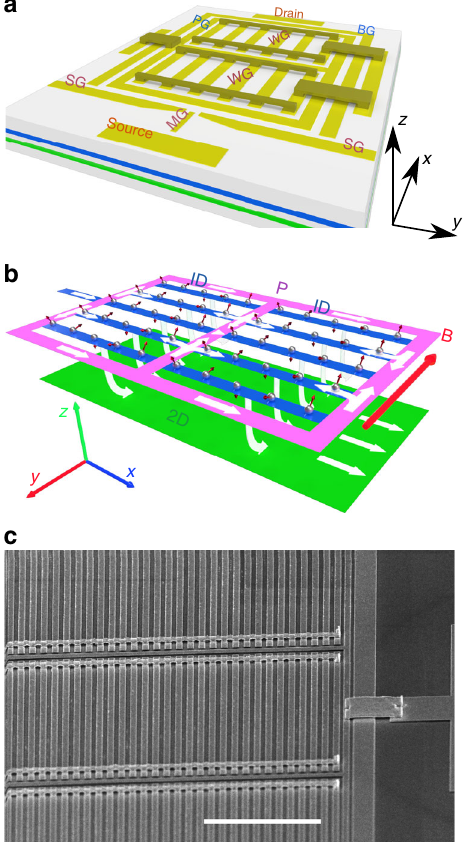
Fig. 3 The 1D – 2D spectrometer device. a Illustration of the 1D – 2D spectrometer device. The control gates are split gate (SG) and mid-gate (MG) (depleting the lower layer but not the top, to inject current into the upper layer), gates de fi ning 1D wires (WG), gate over the parasitic region (PG), and barrier gate (BG) con fi ning the upper layer. Gates are not drawn to scale. In reality, they consist of a three-column array of over 500 wires, each of length 18 µ m and gate width 0.1 µ m, with 0.18- µ m separation (device A) and 10 µ m and gate width 0.3 µ m, with 0.2- µ m separation (device B). b Schematic of current fl ow: current enters the top layer under mid-gate MG at the left, fl ows into 1D wires (blue) via parasitic regions (magenta, labelled P) and tunnels to a lower, 2D, layer and out to a contact at the right. c Scanning electron micrograph of a device, showing the air bridges. The scale bar is 5- μ m